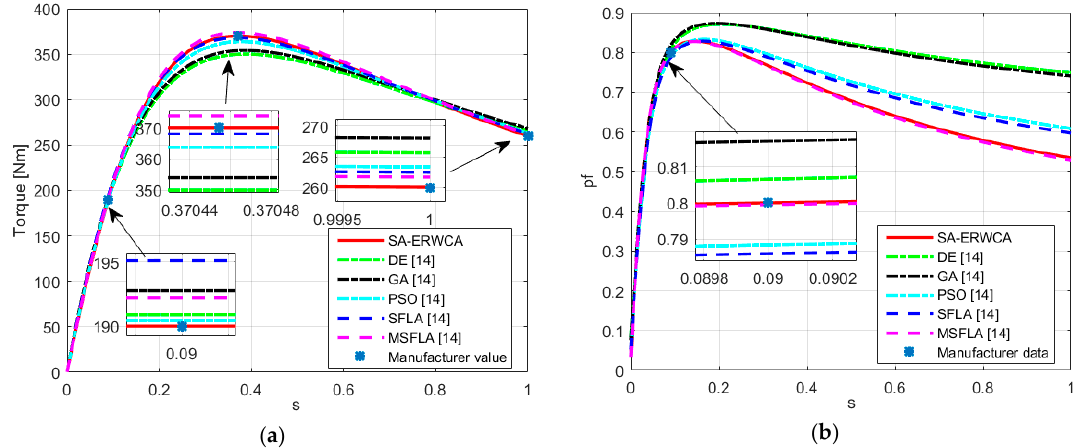
Figure 4. Curves of Machine 1: ( a ) Torque versus slip curve; and ( b ) Power factor versus slip.